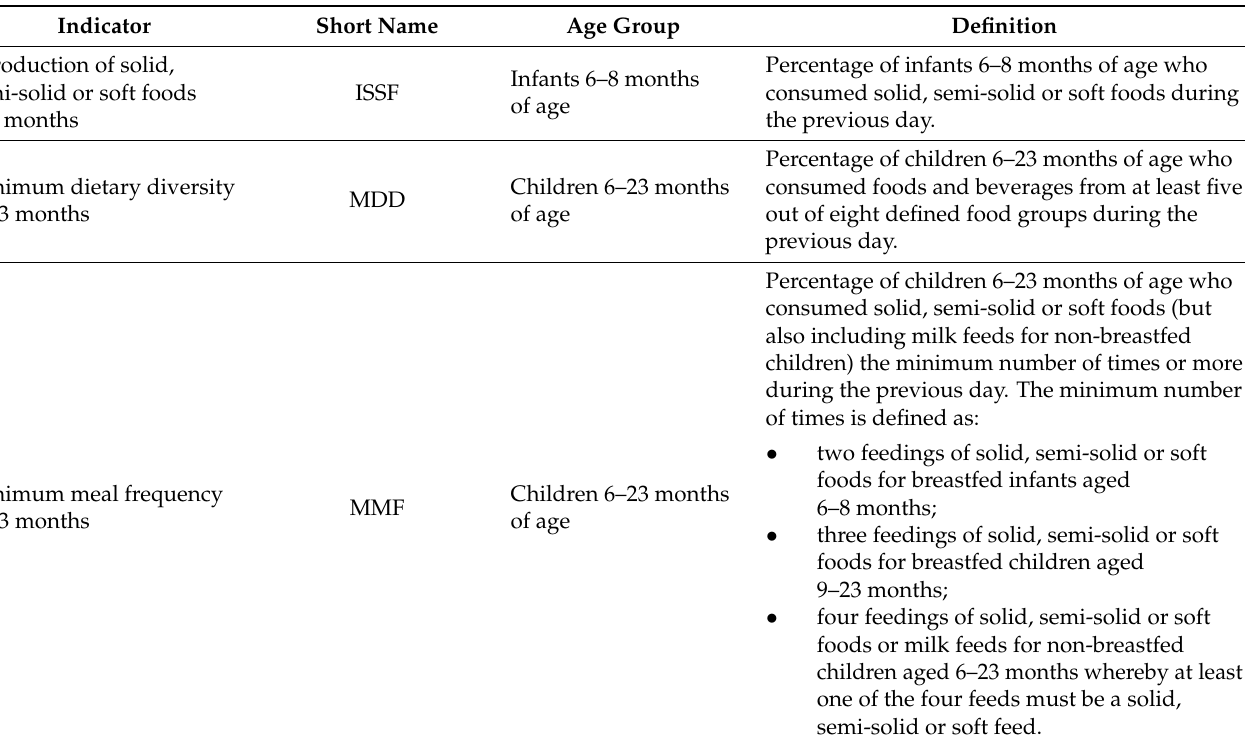
Table 1. WHO complementary feeding indicators